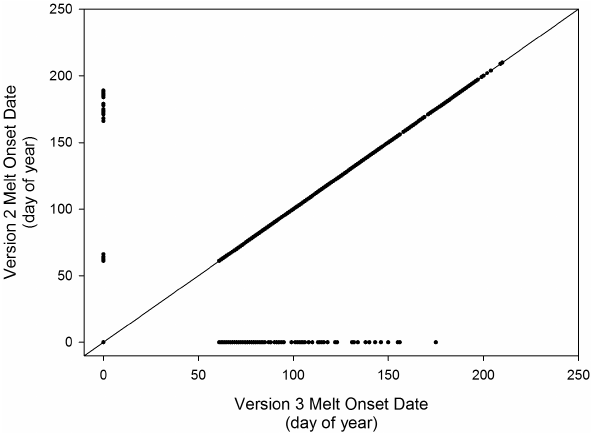
Figure 4. Scatter plot of V3 MO dates versus V2 MO dates for 1983 with 1:1 line.